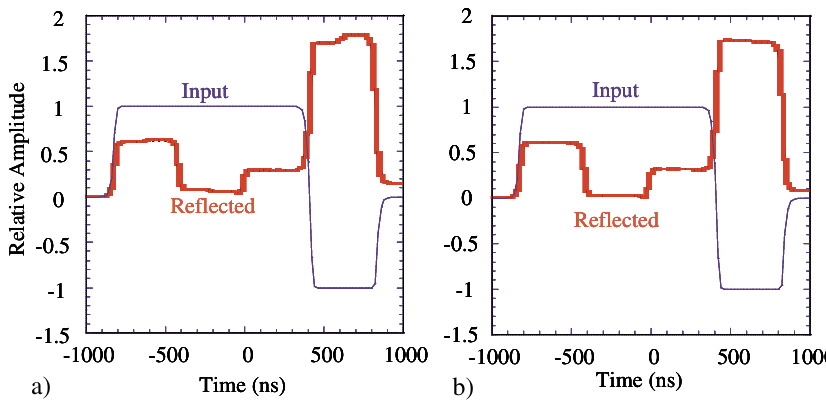
FIG. 16. (Color) Individual amplitude responses for (a) the upper resonant delay line and (b) the lower resonant delay line, measured separately (see Fig. 19). Small mid-time-bin steps indicate mode